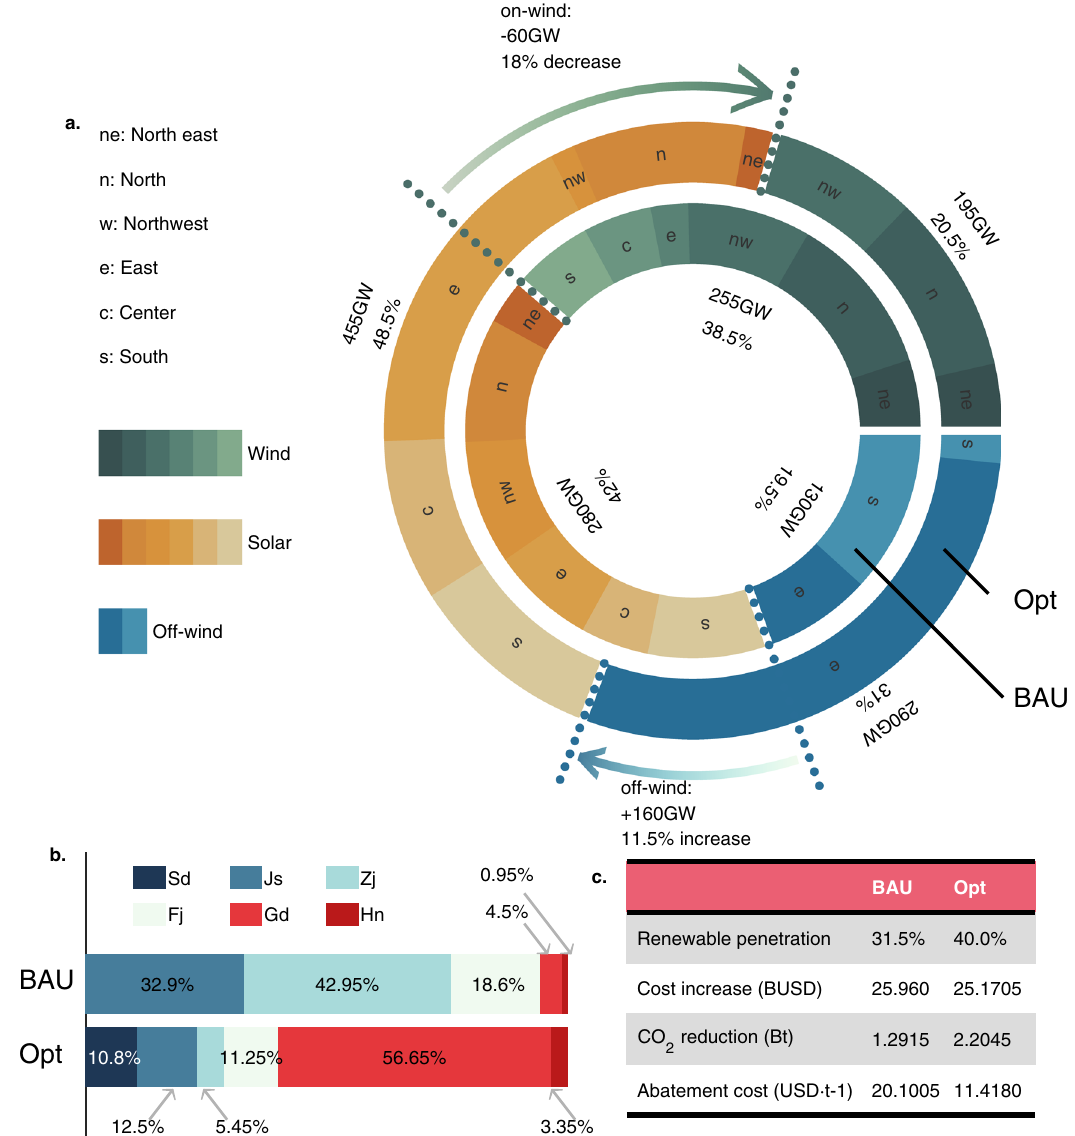
Fig. 4 | Regional distribution of the major renewable alternatives in National planning and our Optimization results. a Regional distribution of the onshore wind,solarand offshorewindpowerintheNationalplanning(innercircle)and our optimizationplanning(outercircle),witheachrenewablealternativecharacterized by color types (summarized in left legend). Renewable allocation in each region is calibrated with color depth and regional abbreviation (also summarized in left